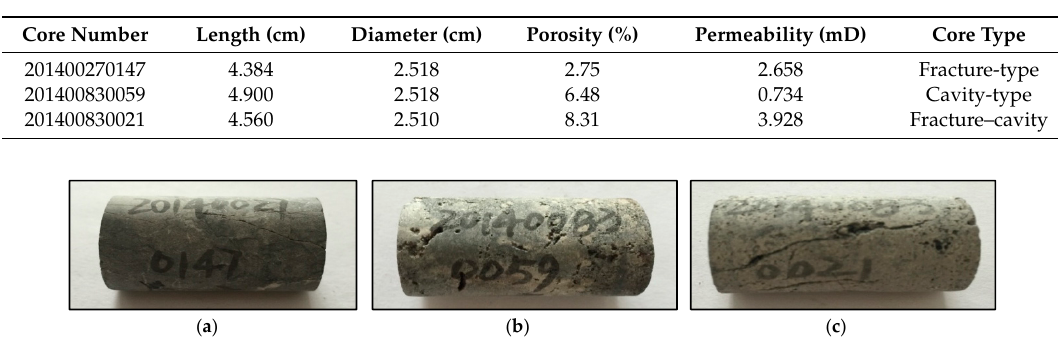
Figure 1. Photographs of cores. ( a ) 201400270147; ( b ) 201400830059; ( c ) 201400830021.